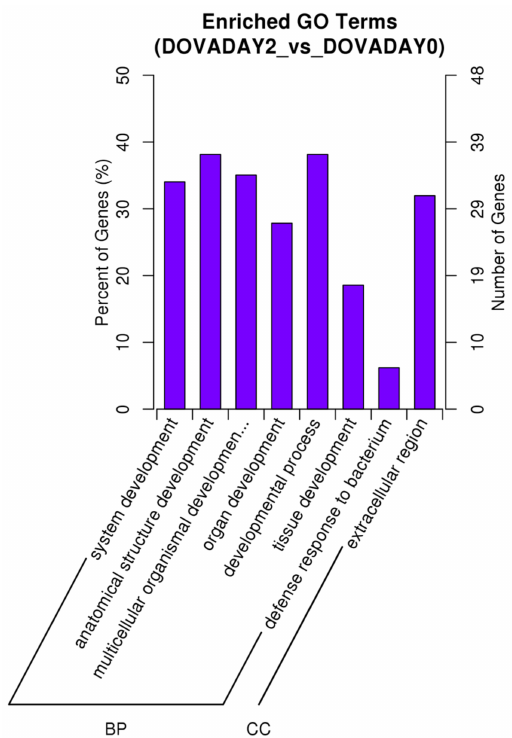
Figure 4. GO enrichment plot of differentially expressed mRNAs between DOVADAY2 and DOVADAY0. BP: biological process; CC: cell composition; MF: Molecular